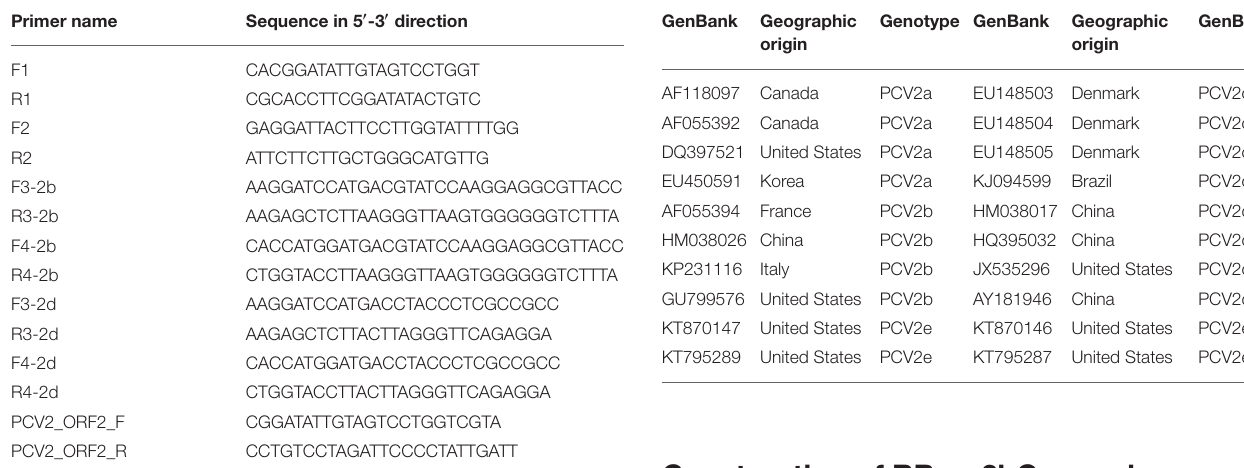
TABLE 1 | Primer pairs used in this study. TABLE 2 | 20 PCV2 reference strains used for sequence